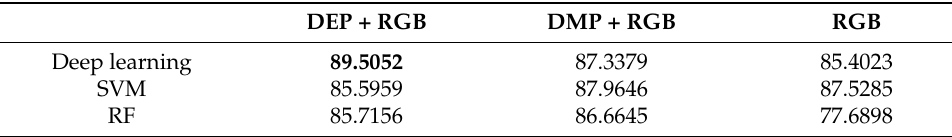
Table 8. Overall accuracy for World-View 2 dataset.